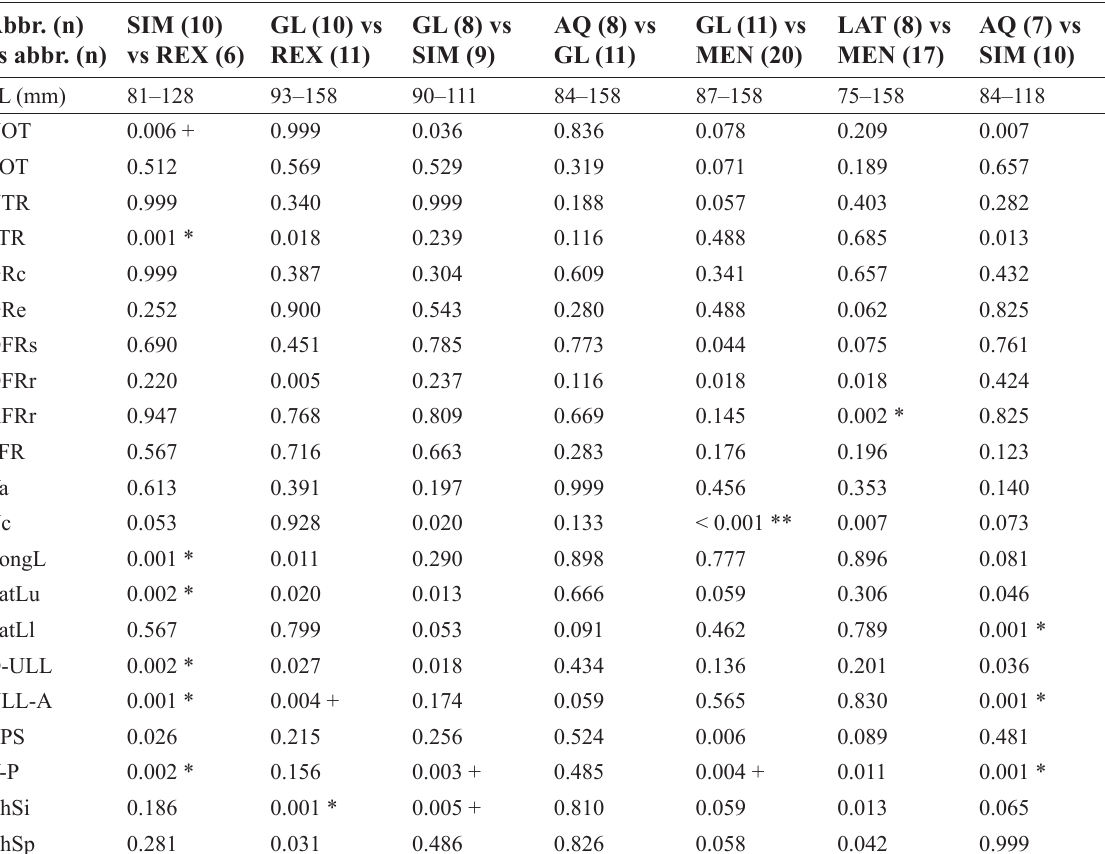
Table S8. (continued). Inter-species pairwise comparisons of the species of Haplochromis from the Lake Edward system with a piscivorous morphology by means of Mann-Whitney U tests. Each pairwise test was performed on subsets of specimens of a similar length class [MW U (SL): P > 0.5]. Sequential Bonferroni corrections for multiple tests were performed on each inter-species pair separately for measurements and counts separately. Raw p-values are shown and significance after sequential Bonferroni correction is indicated: P < 0.1 +, P < 0.05 *, P < 0.01